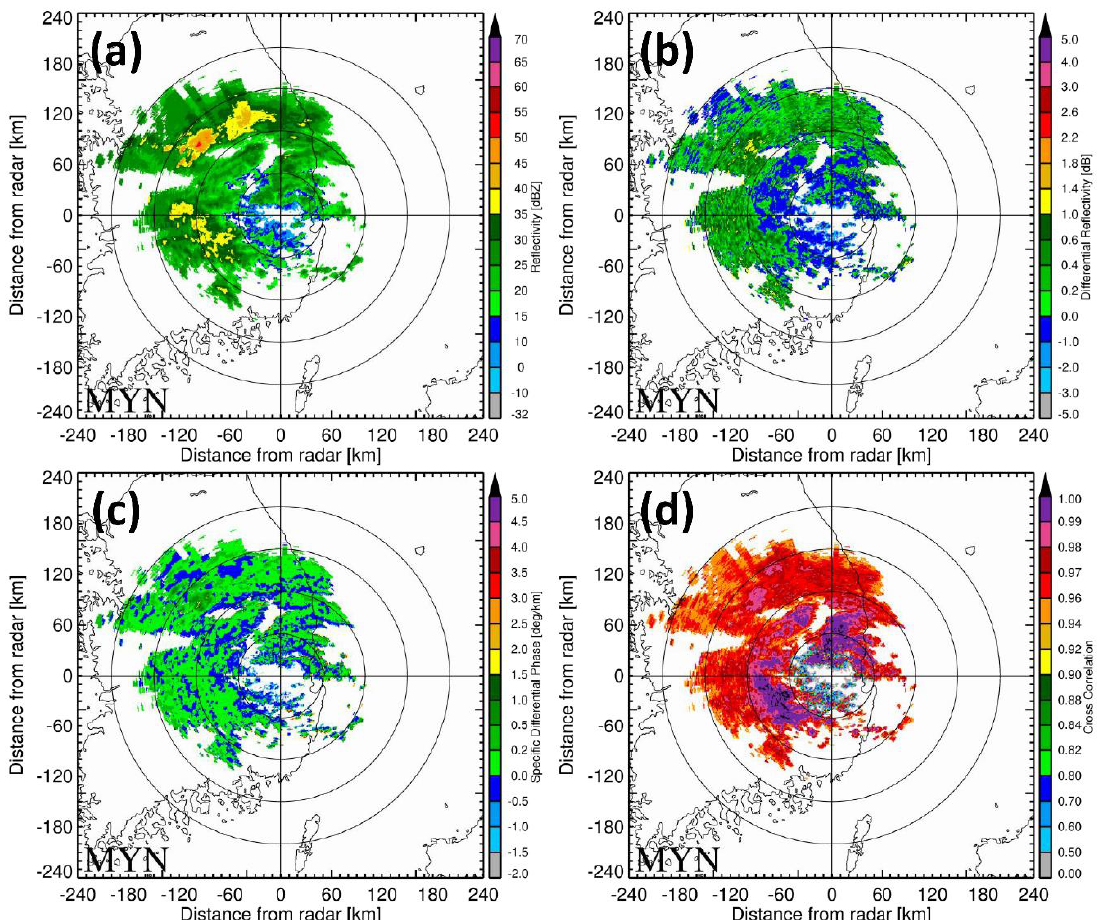
Remote Sens. 2021 , 13 , 2039 12 of 21 Figure 5. Radar measurements, reflectivity (Z H ), differential reflectivity (Z DR ), specific differential phase (K DP ), and cross- Figure 5. Radar measurements, ( a ) reflectivity (Z H ), ( b ) differential reflectivity (Z DR ), ( c ) specific differential phase (K DP ), correlation coefficient ( 𝜌 𝐻𝑉 ), at 09:40 KST on 31 July 2017. and ( d ) cross-correlation coefficient ( ρ HV ), at 09:40 KST on 31 July 2017.